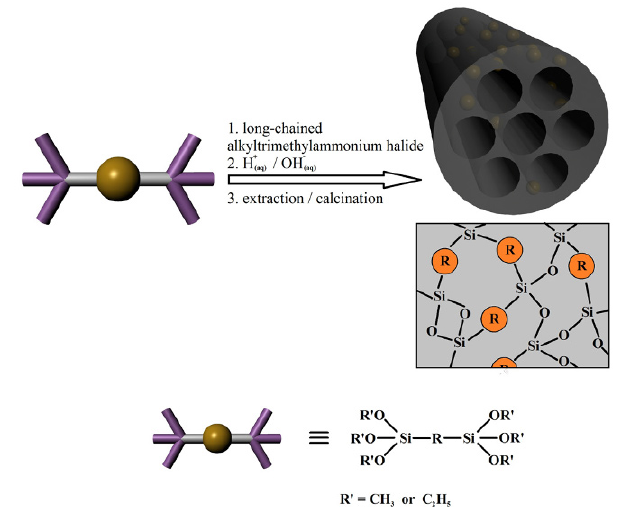
Figure 3. Preparation of periodic mesoporous